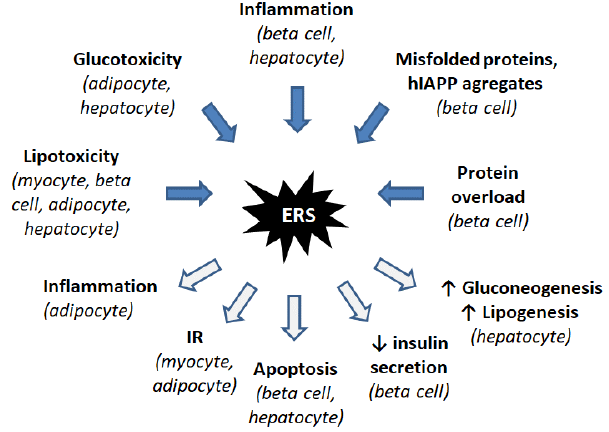
Figure 3. Induction and consequences of ER stress in insulin resistance and diabetes. In diabetes, lipotoxicity and glucotoxicity induce ER stress in several cell types. Inflammation is another inducer of ER stress. In beta cells, intense insulin production leads to misfolded insulin and hIAPP aggregates, which induce ER stress. ER stress triggers various responses, including inflammation, IR, apoptosis, decrease of insulin secretion, and increase of gluconeogenesis and lipogenesis, depending on the considered cell